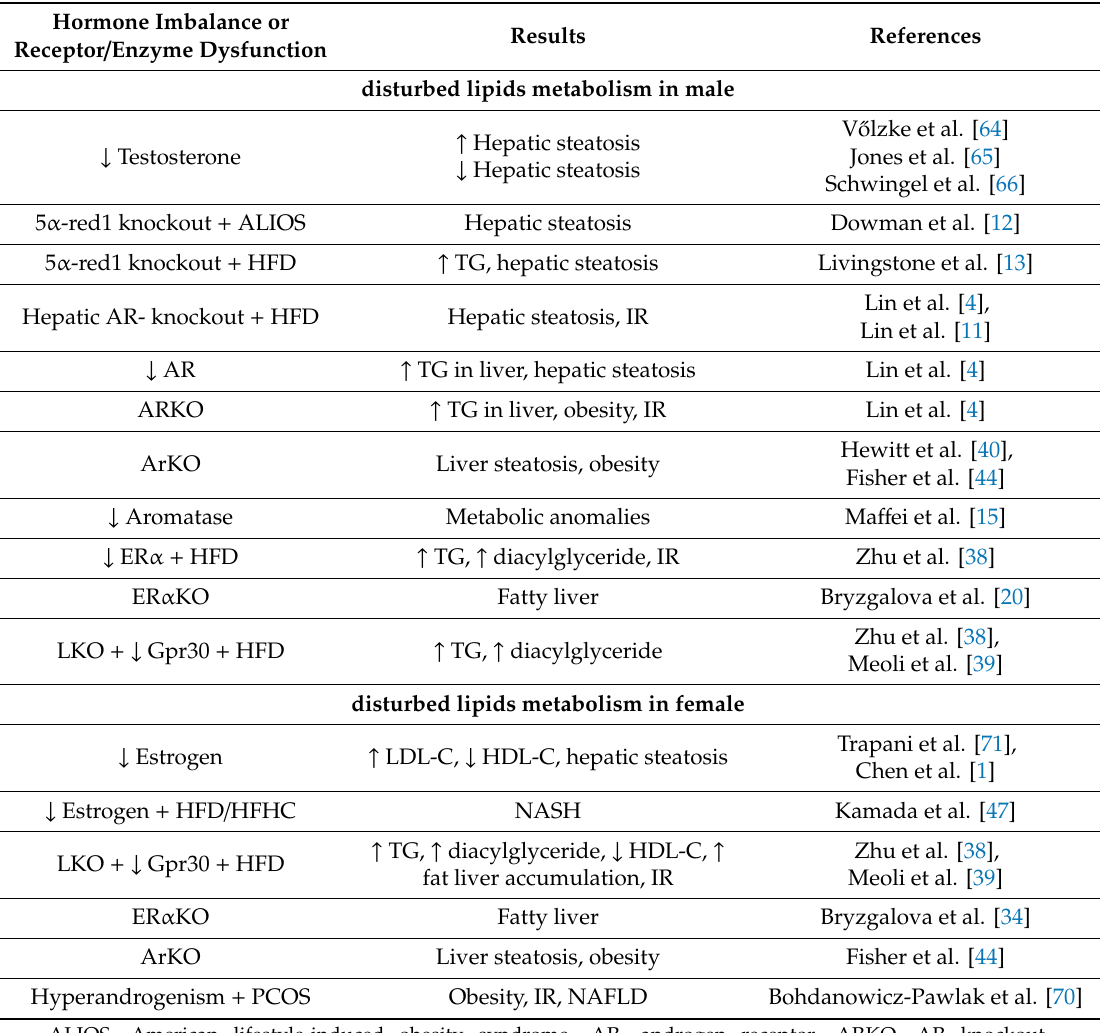
Table 2. Summary data on impact of the hormone imbalance, disturbance of the sex hormone receptors and the enzyme activity / expression on the hepatic metabolism of lipids in relation to the gender as a cause of many physiological dysfunction, syndromes and